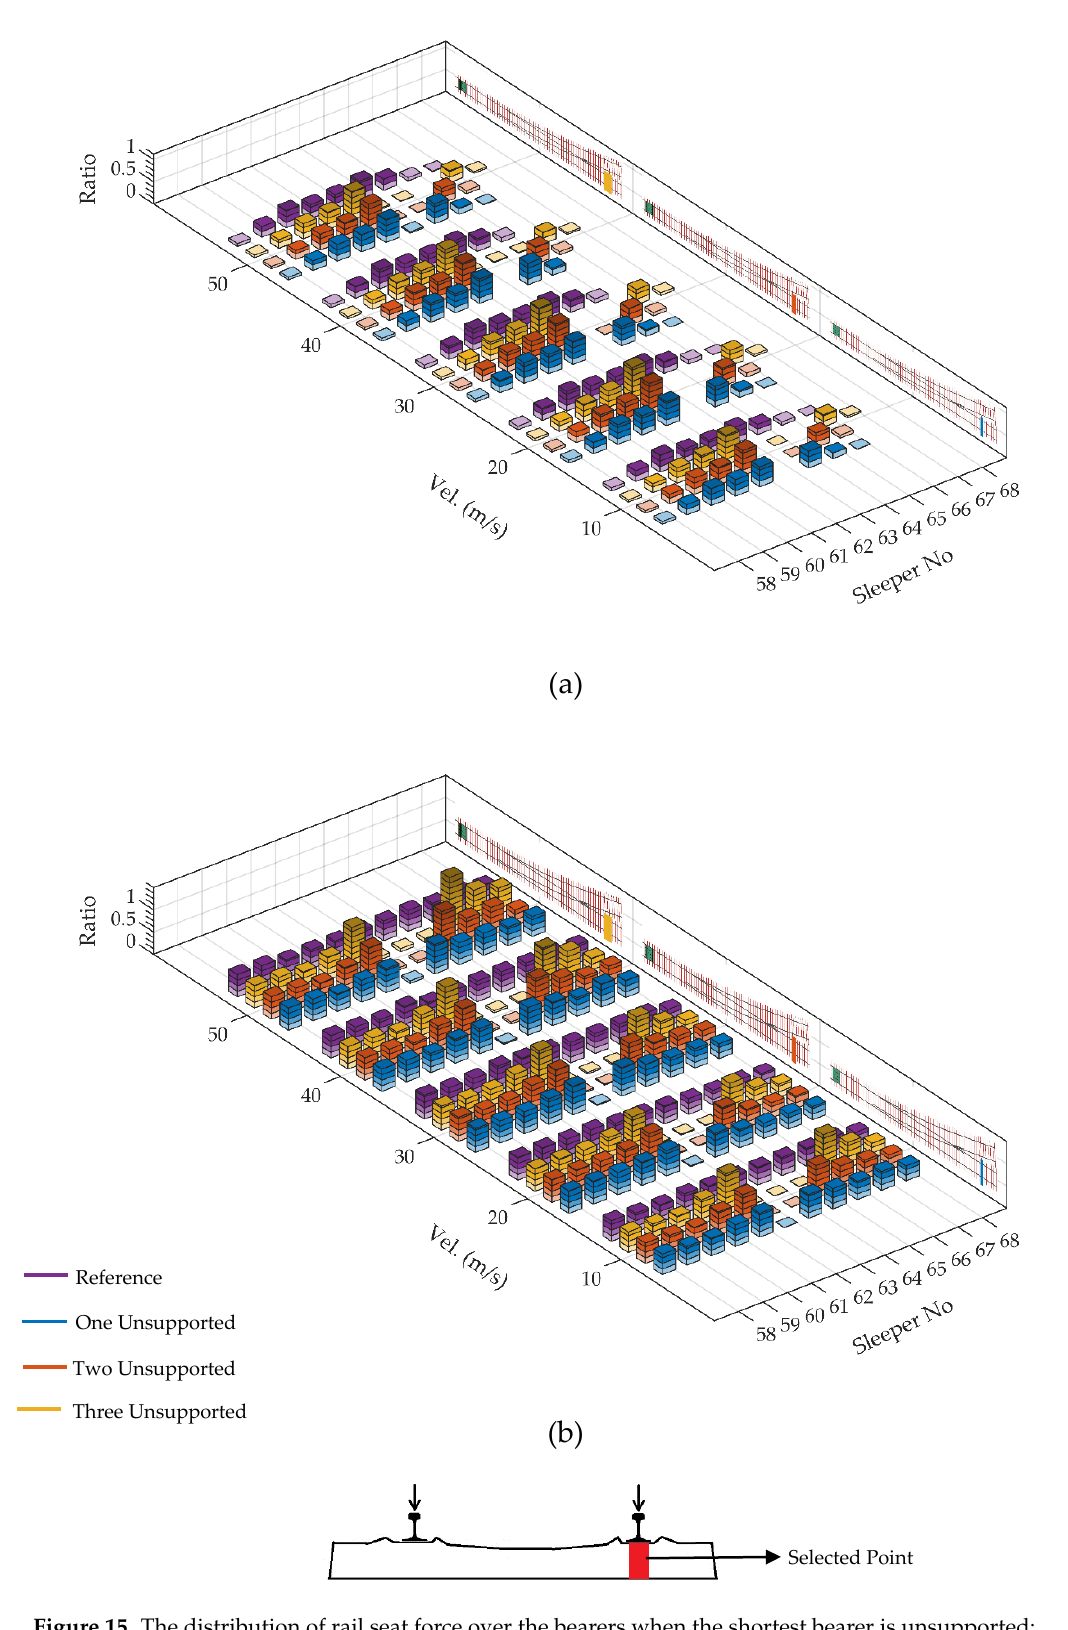
Figure 15. The distribution of rail seat force over the bearers when the shortest bearer is unsupported: ( a ) at particular time when the front wheel is on the bearer with number 62; ( b ) when maximum occurs at each bearer.